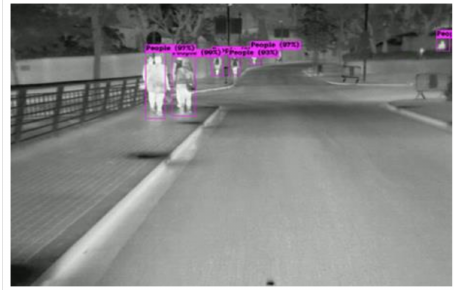
Figure 12. Detection of walking people in CVC dataset.